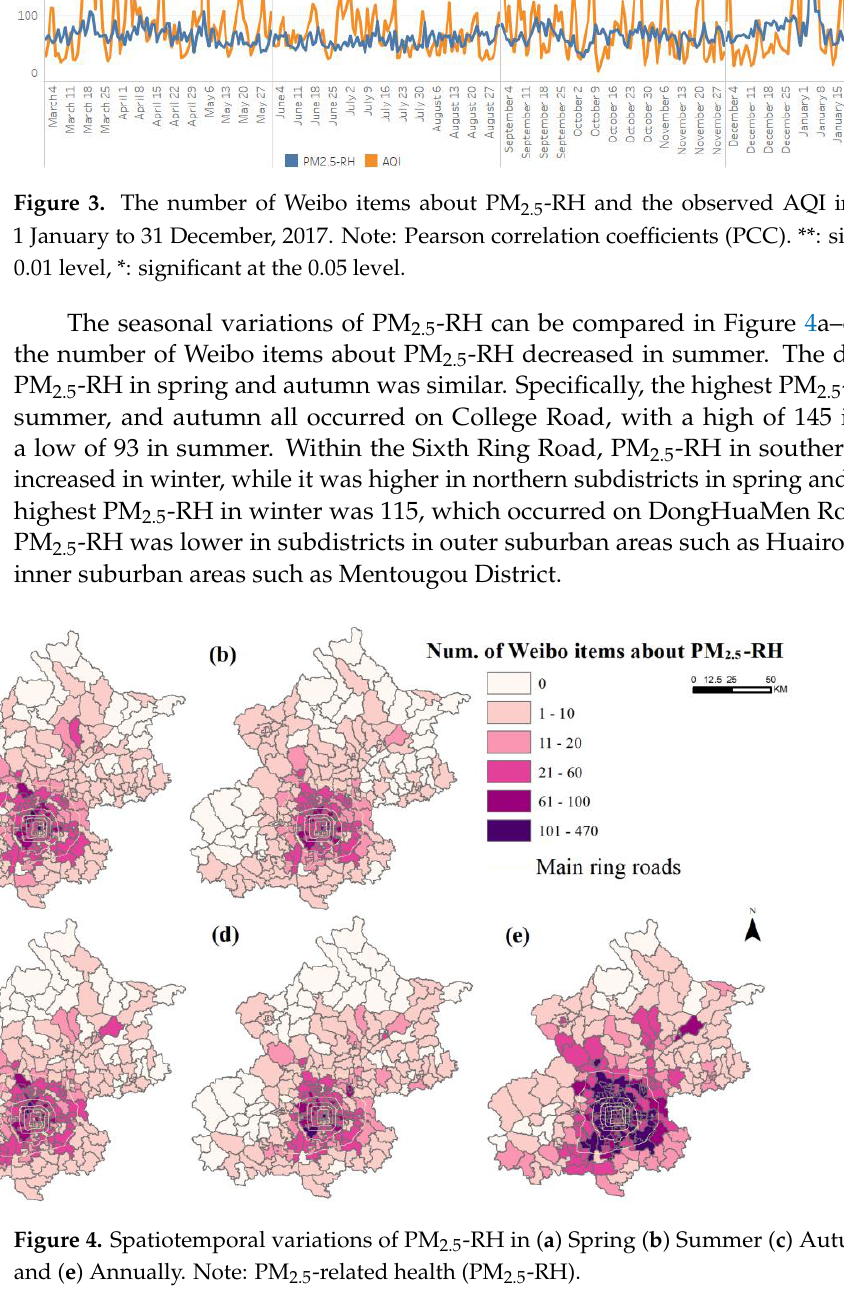
Figure 5. Spatial distribution of eight annual associated factors. 3.2. Performances of the GWR Models In this research, the GWR models were employed to explore the relationship between the associated factors and PM 2.5 -RH, which were completed in GWmodelS. We constructed five models with the dependent variable (PM 2.5 -RH) and eight independent variables in the four seasons and annually, respectively, namely: road network density, land use mix, NDBI, AQI, temperature, NDVI, NTL, and population density. Figure 5 shows the spatial distribution of eight associated factors annually at the subdistrict level (only annual values were shown due to the limitation of space). To eliminate the influence of different units when conducting the models, all the variables were standardized. In addition, collinearity tests for the eight explanatory